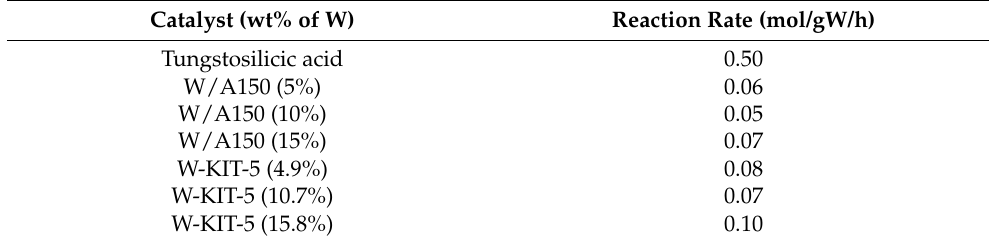
Table 2. Reaction rate of tungstosilicic acid and synthesized